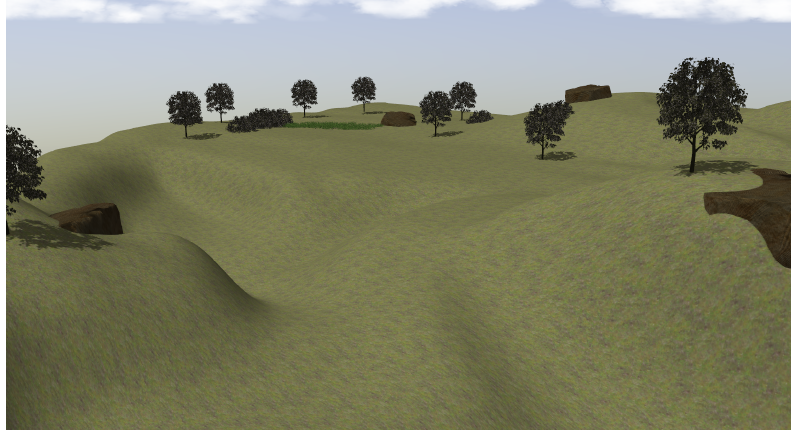
Figure 15. View of the modeled natural environment for training at the third